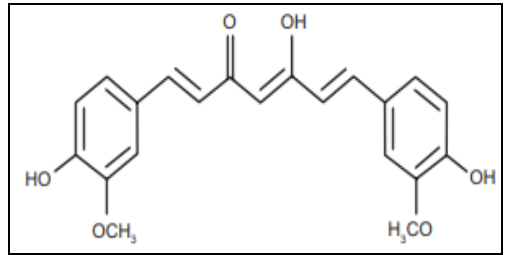
Figure 2. Chemical structure of curcumin (54) Biacalin